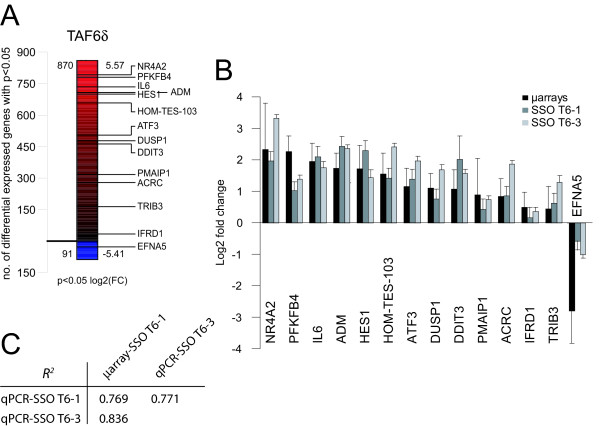
Transcriptome analysis following SSO induction of TAF6δ. (A) Expression levels of mRNAs from T6-1 SSO-treated HeLa cells were individually compared to those from control oligonucleotide-treated HeLa samples by genome-wide microarray analysis. The absolute number of probes detecting statistically significant (P < 0.05) up- or down-regulation following TAF6δ induction is shown to the left of each bar; the positive or negative logarithmic (base two) fold-change is shown to the right. The red gradient indicates positive, and the blue gradient negative fold changes in expression. The relative position of the TAF6δ-regulated genes that were further validated by qPCR (panel B) is indicated on the right. (B) Independent verification of gene expression changes by quantitative real-time RT-PCR. HeLa cells were transfected with SSO T6-1 (dark grey bars) or SSO T6-3 (light grey bars) to induce endogenous TAF6δ. 18 hours post-transfection total RNA was analyzed by quantitative real-time PCR and compared with microarray measurements from HeLa cells transfected with SSO T6-1 (black bars). Error bars indicate standard deviation of three independent transfections. (C) The Pearson correlation coefficients associated with panel B.